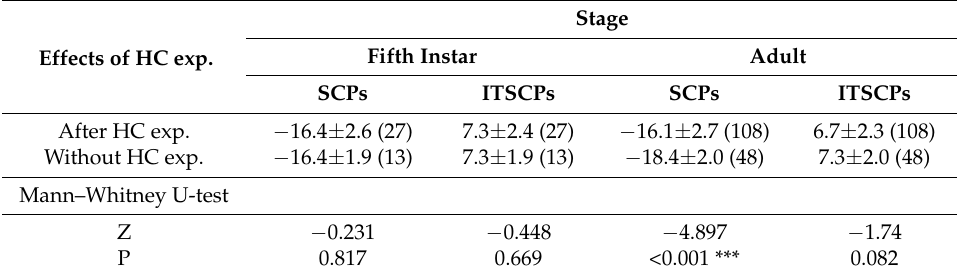
Table 3. Effect of heat coma temperature (HCT) measurement on the subsequent measurement of super cooling points (SCPs) and increased temperature at SCPs (ITSCPs) in Halobates micans during the cruise MR11-07 (Table A1(I)) . Data on specimens collected at around 08 ◦ 00 (cid:48) S, 080 ◦ 30 (cid:48) E was analyzed. Experiments were performed during the period from 1 to 23 October 2011 in wet laboratory 2 of R/V Mirai (Mean ± SD(n)).